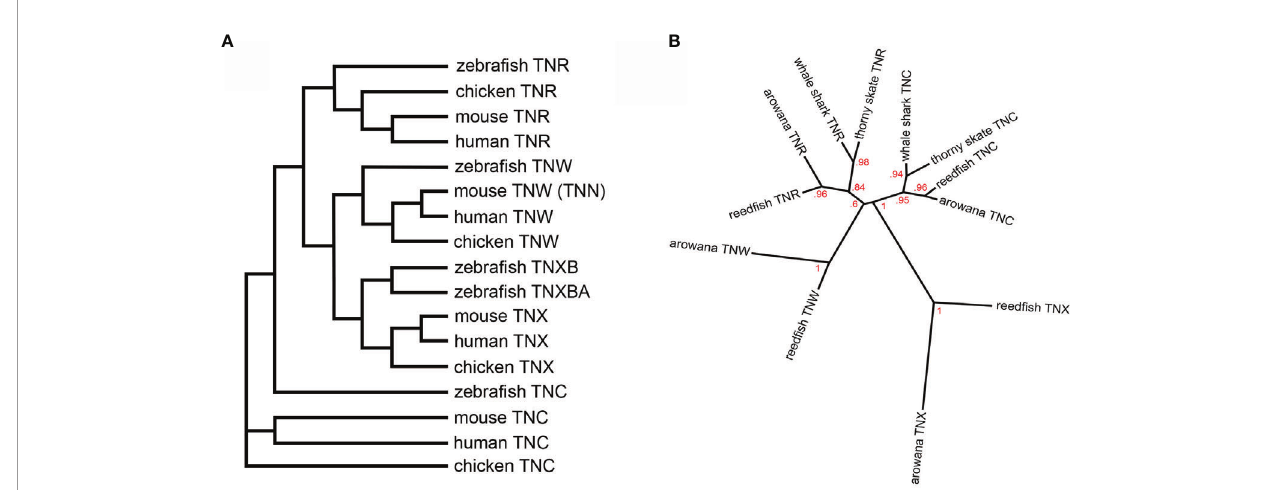
FIGURE 1 | (A) A dendrogram constructed using the fi brinogen-related domain amino acid sequences of zebra fi sh, chicken, mouse and human tenascins. The tree was constructed using the default tools and parameters at NGPhylogeny.fr (5). The murine tenascin-W (TNW), originally named tenascin-N (TNN), segregates to the TNW clade. (B) A phylogenetic tree constructed using the fi brinogen-related domain amino-acid sequences of tenascin-C (TNC) and tenascin-R (TNR) from the cartilaginous thorny skate and whale shark, as well as the ancient bony reed fi sh and arowana, and from the fi brinogen-related domains of reed fi sh and arowana tenascin-X (TNX) and TNW. The tree was constructed using the same parameters as Adams et al. (6) and branch support is indicated. TNW co-evolved with the bony fi shes, most likely from a duplication of the TNR gene. See text for